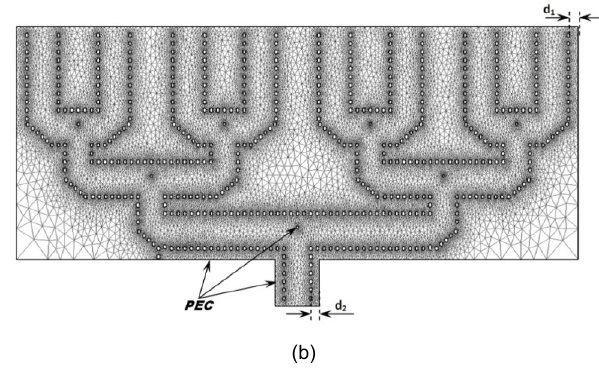
FIGURE 7. The Eight-way power divider structure in H-plane with chamfered bend and hole via center, (a) the parameters are defined in table.1 and L1 =